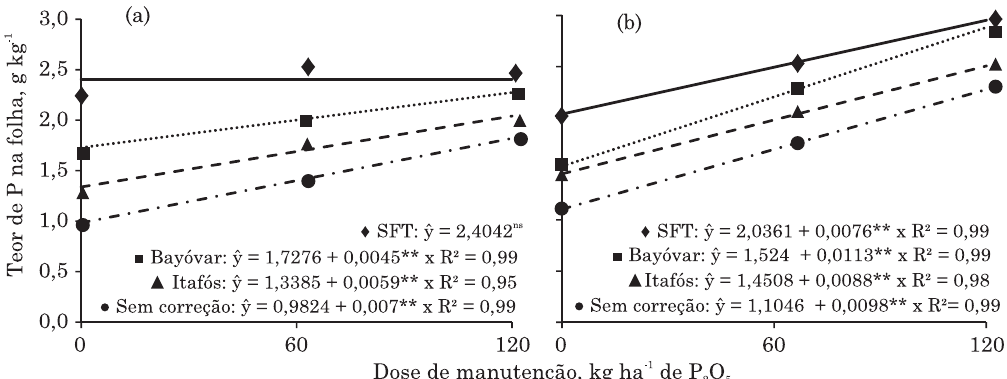
Figura 2. Teor de P nas folhas do milho em função da adubação de manutenção para cada fonte de correção em 2011 (a) e para o seu efeito residual em 2012 (b). ns e **: não significativo e significativo a 1 %,